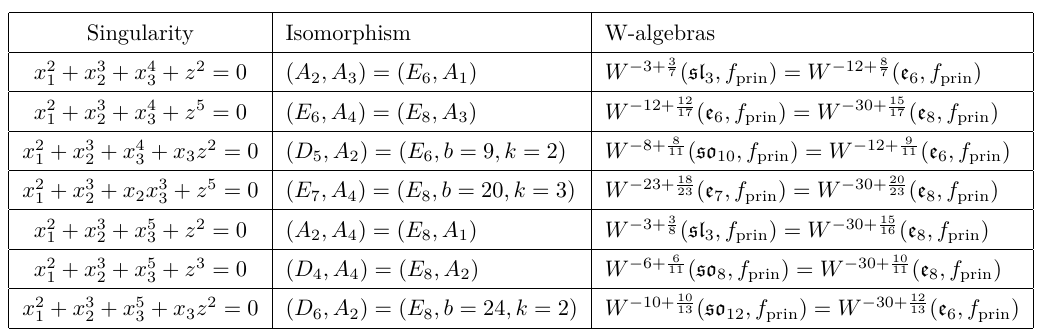
Table 18 . Here we first wrote the equivalence of the 3-fold singularity in the notation of ( G, G 0 ) , where G denotes the corresponding ADE singularity of type G , then we listed the equivalence between